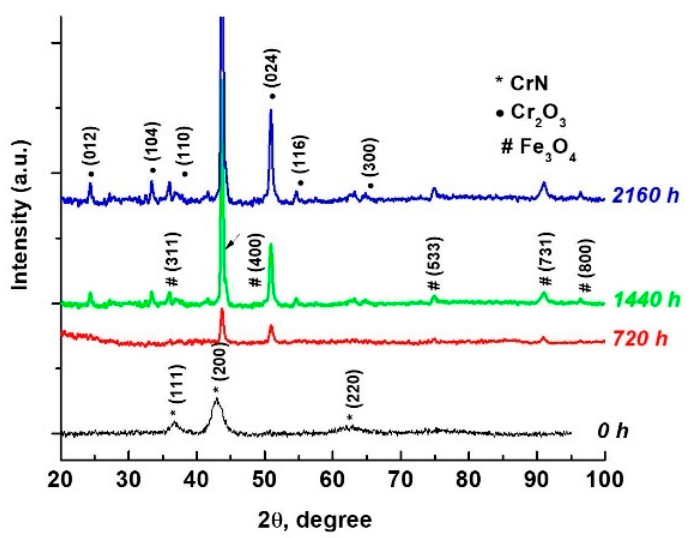
Figure 6. XRD diffractogram of coated 310 H SS samples before and after different periods of ex- in water at 550 ◦ C and 25 posure in water at 550 °C and 25 MPa.